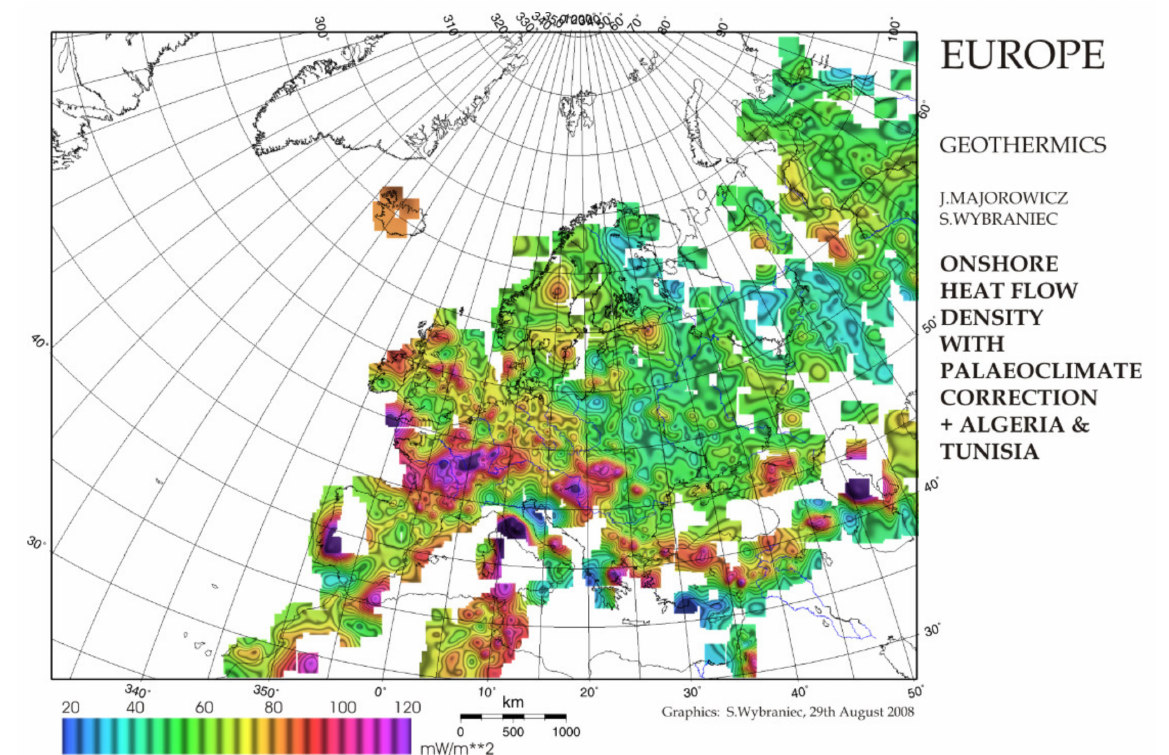
Figure 9. Heat flow map of Europe based on forcing heat flow values corrected for glacial-postglacial (Majorowicz and Wybraniec, redrafted unpublished version). Q data used later in a published paper by Majorowicz and Wybraniec [22] are available upon request as an Excel